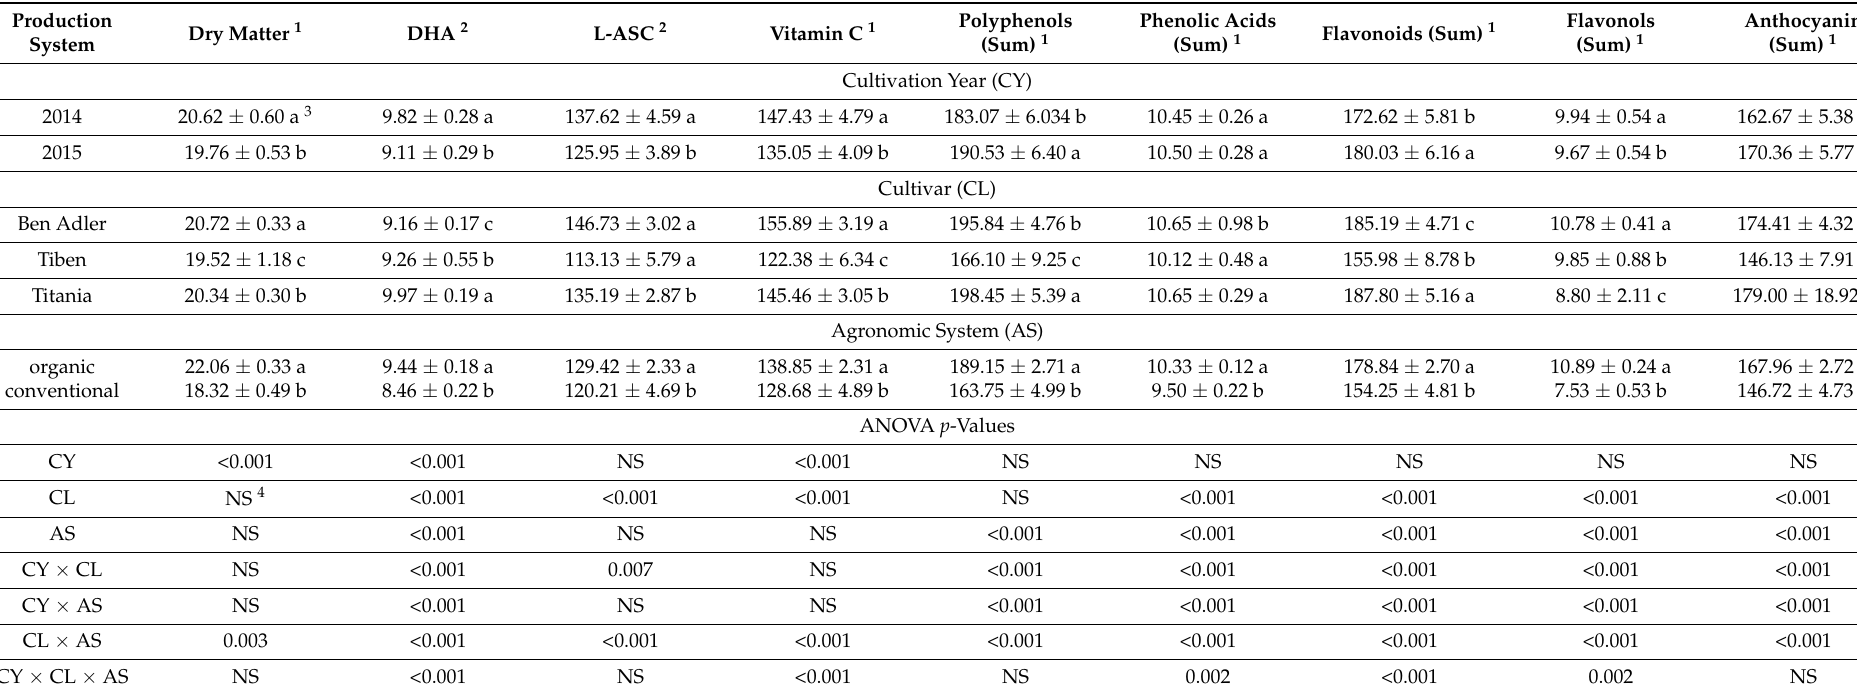
Table 2. The main effects of, and among, cultivation year, cultivar and agronomic system on the content of dry matter, vitamin C, selected groups of phenolic compounds and anthocyanins in blackcurrant fruits (in mg 100 g